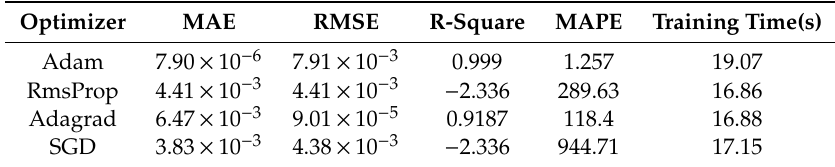
Table 1. Evaluation indexes of di ff erent